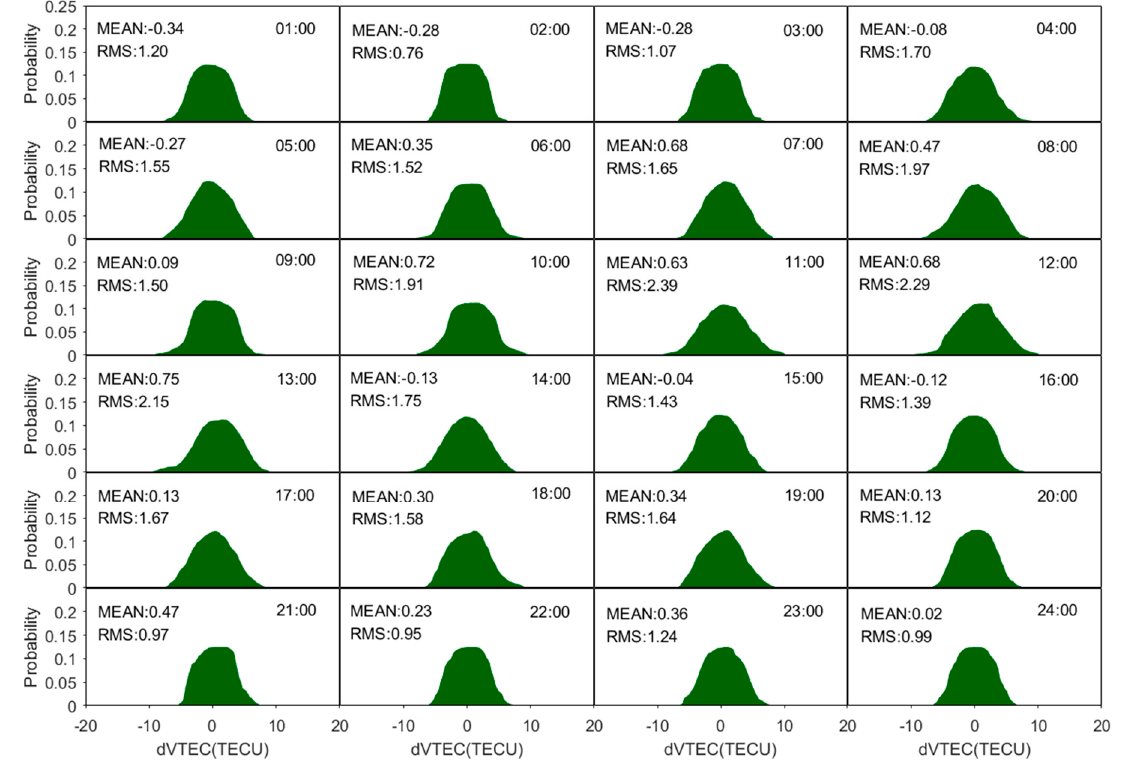
Figure 7. Post-residual distribution of refinement modeling in DOY 78 of RRTGIM-1.